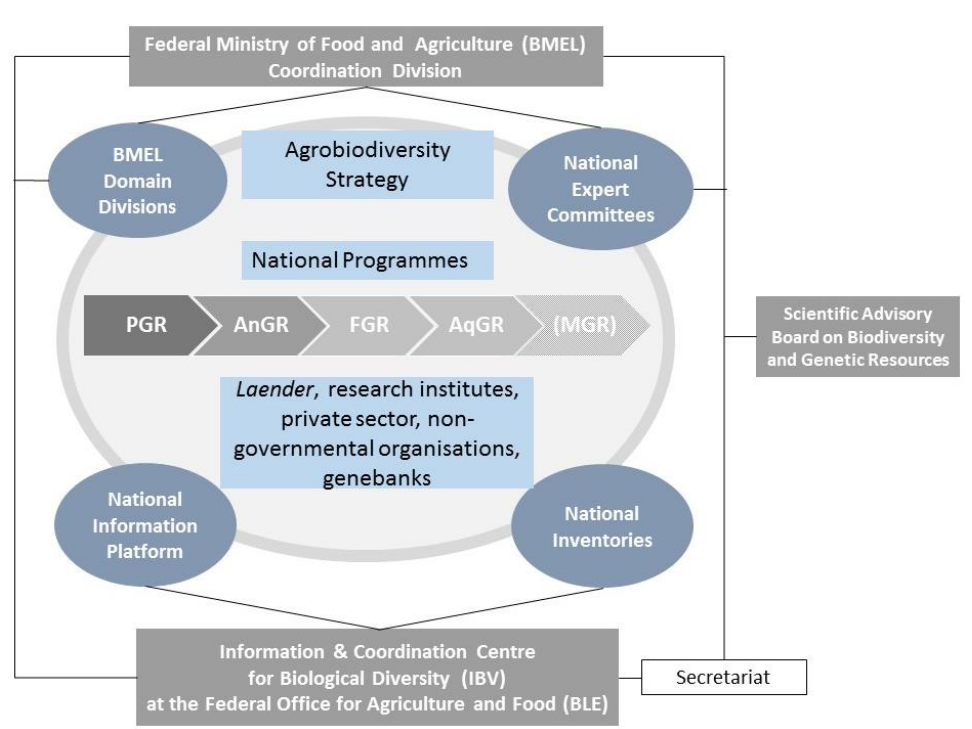
Figure 1. Coordination and governance structure of the National Concept for the Conservation and Sustainable Use of Genetic Resources for Food, Agriculture and Forestry (revised from [17]).